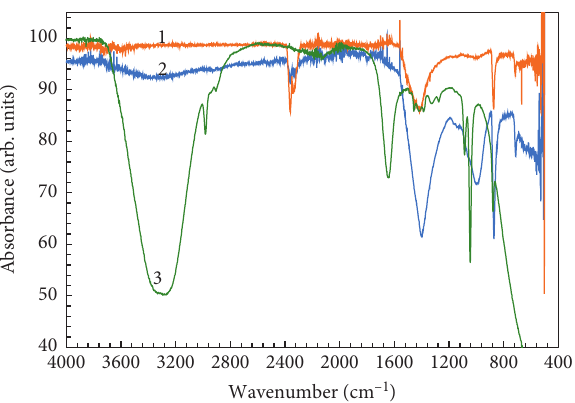
Figure 7: FT-IR spectra of crystalline calcium carbonate grown in the absence of RCE (1), presence of RCE (2), and radish cake extract Table 5: Peaks from FT-IR spectra samples: RCE ( a ), the scale film (b), and scale film after exposure in the presence of RCE (c). Wavenumber (cm − 1 )